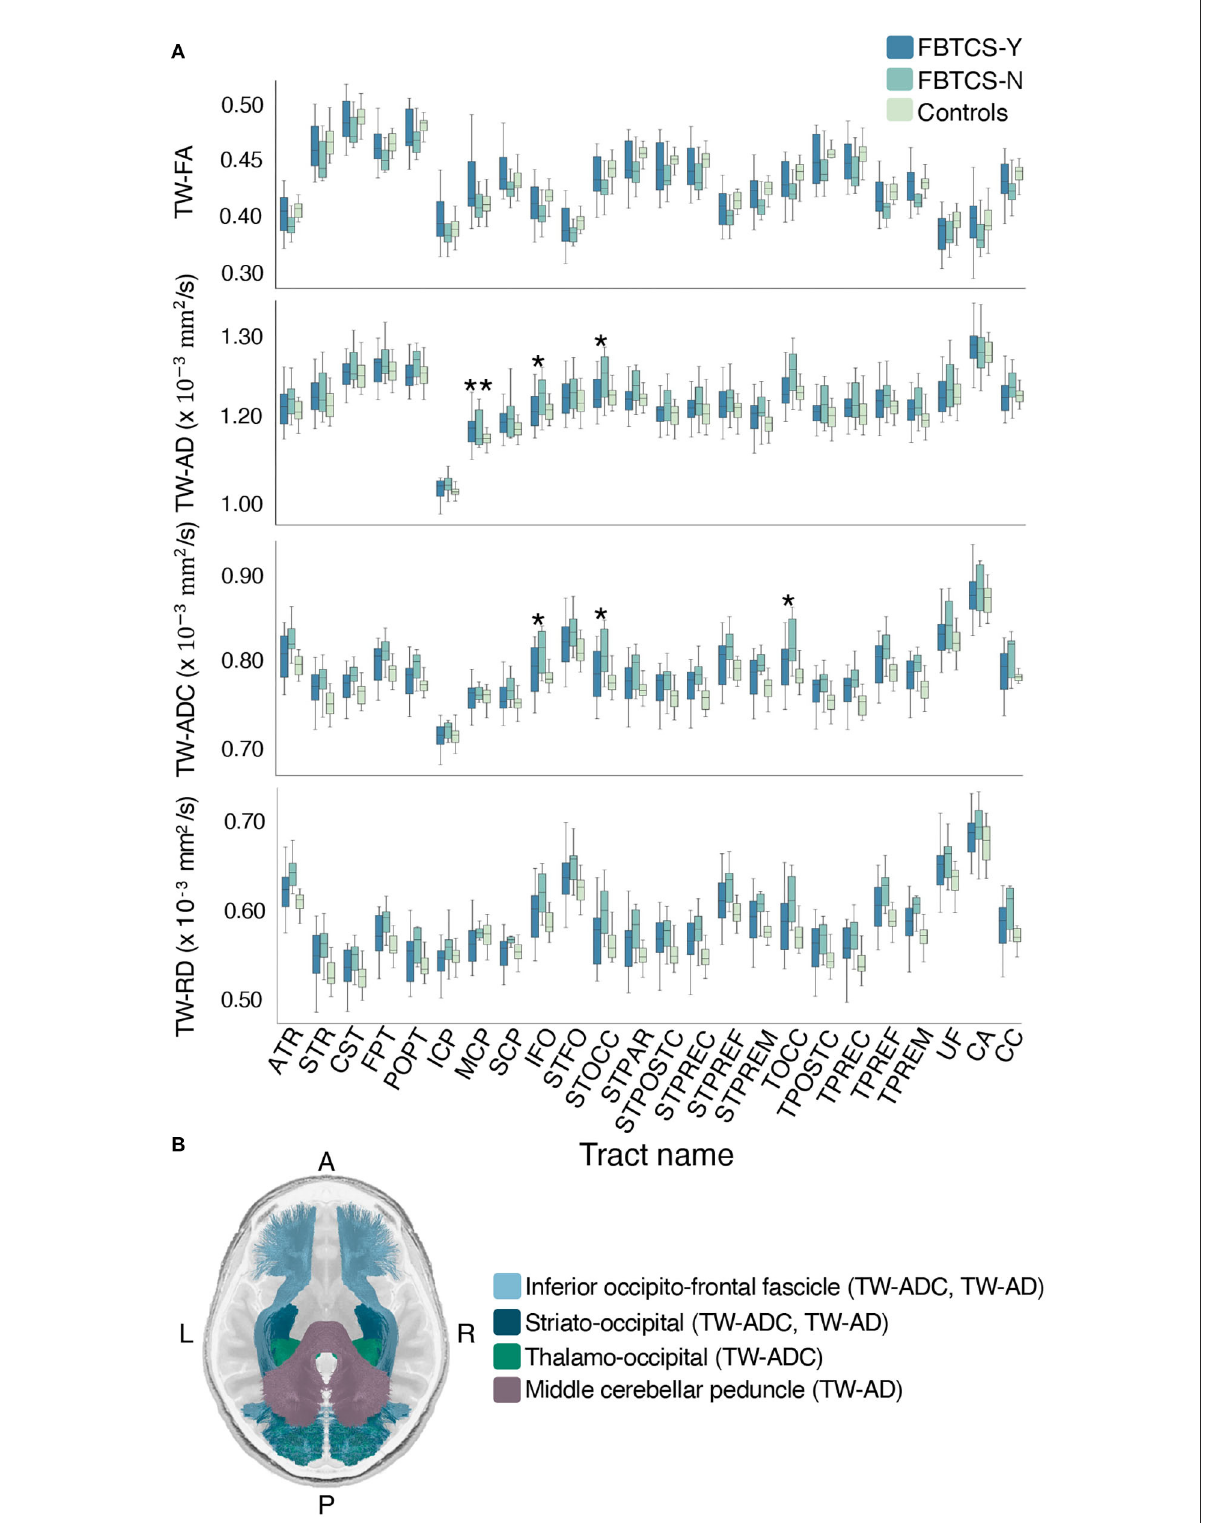
FIGURE4 Mean group differences in TW-TM for each whole brain tract. Grouped boxplots for each TW-TM for each whole brain tract are shown in (A) . A single asterisk denotes the tracts where the mean TW-TM difference between the two patient groups was significant ( p < 0.05),